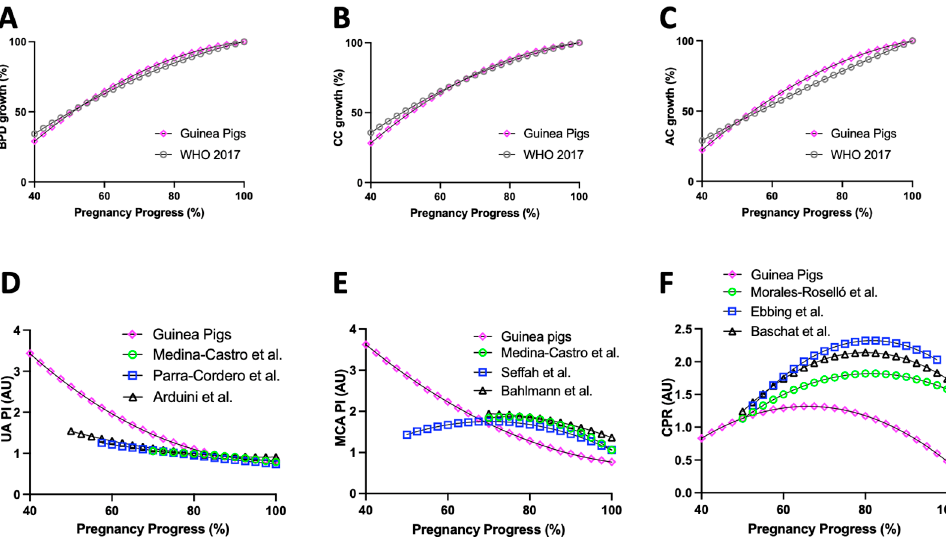
Figure 7. Guinea pig and human fetal ultrasound variables across pregnancy. Guinea pig and human ( A ) biparietal diameter (BPD), ( B ) cranial circumference (CC), and ( C ) abdominal circumference (AC) acceleration across pregnancy and pulsatility index (PI) of ( D ) umbilical artery (UA), ( E ) middle cerebral artery (MCA), and ( F ) cerebroplacental ratio (CPR) from 40% of pregnancy until term. WHO 2017 [19], Medina-Castro et al. [24,25], Parra-Cordero et al. [26], Arduini et al. [27], Seffah et al. [28], Bahlmann et al. [29], Morales-Roselló et al. [30], Ebbing et al. [31], and Baschat et al. [32] are studies based on human data.